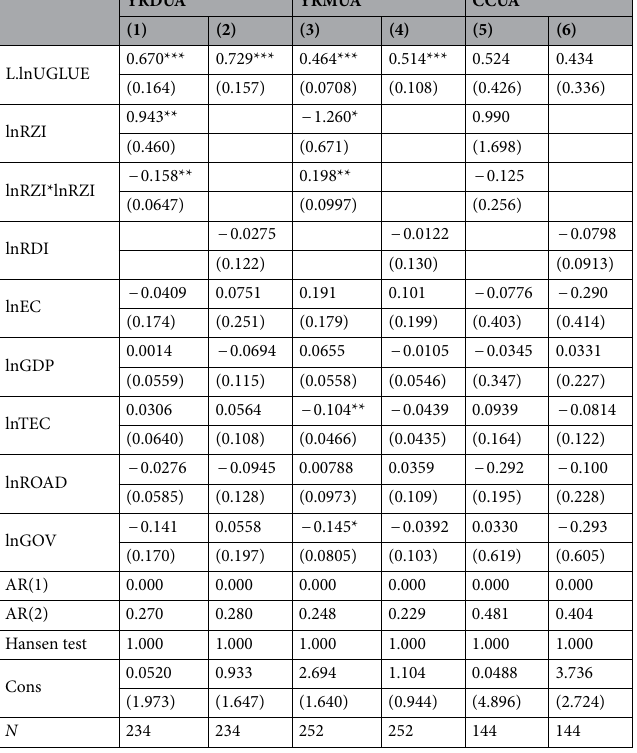
Table 5. Estimated results of regional